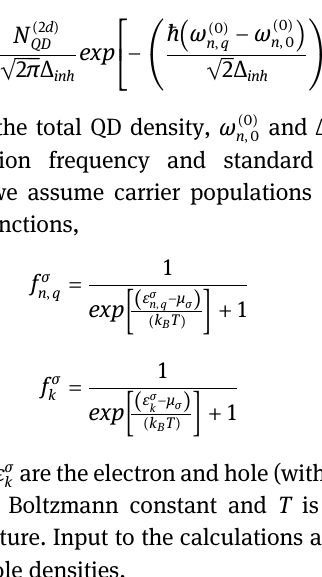
2, and 3, respectively. Also present is a sharp absorption edge at 1.2 eV from the GaAs QW exciton. The calculations are for a relatively uniform QD distribution, with inhomo- geneous width Δ = 10 meV, which translates to a spon- inh taneous emission linewidth (full-width at half-maximum) of Δ = 24 meV. The conversion is made by solving Eqs. sp